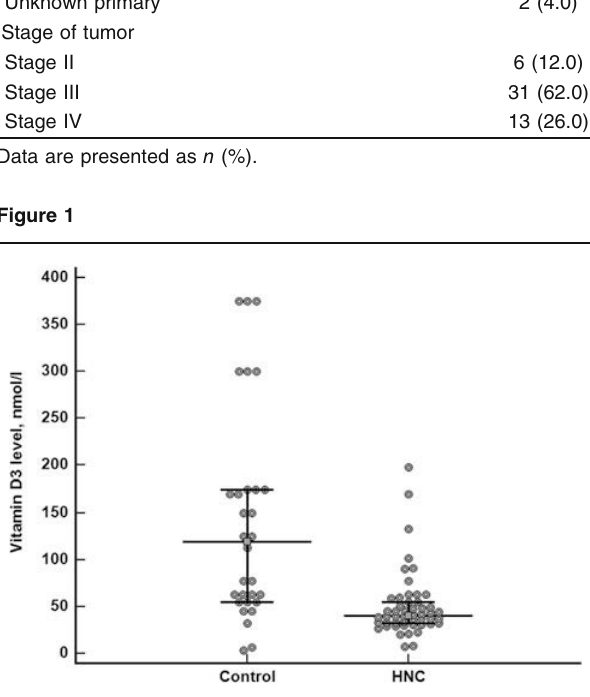
Vitamin D 3 level in cases with HNC and controls. Circular markers represent individual observations. Squared marker with traversing horizontal line represents the median (second quartile). Error bars represent the 25th and 75th percentiles (first and third quartiles, respectively). HNC, head and neck cancer.